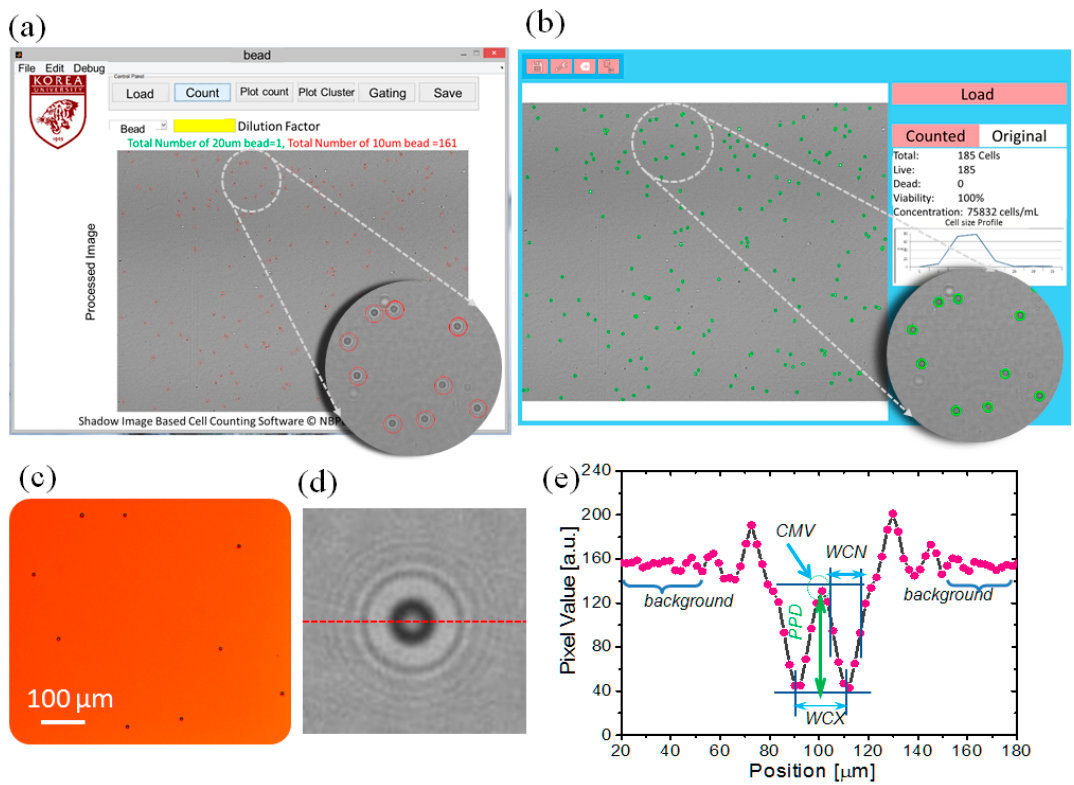
Figure 3. Snapshot of the custom-developed application software. ( a ) Snapshot of custom-developed Windows application software; ( b ) optical micrograph of region of interest at 100× magnification; ( c ) snapshot of custom-developed Android application; ( d ) diffraction pattern of a single microparticle; ( e ) intensity profile of the diffraction pattern in ( d ) explaining the custom-developed diffraction parameters along the dotted red line in ( d ).